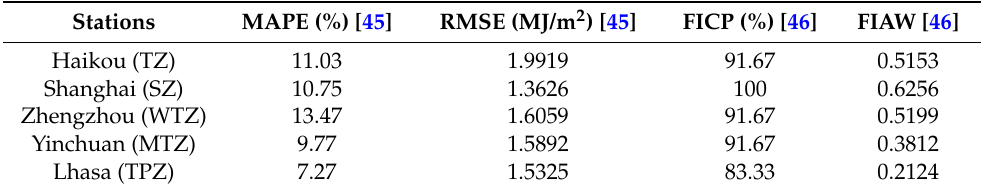
Table 7. The index results of monthly mean solar radiation forecasting for 2015 in different climates of